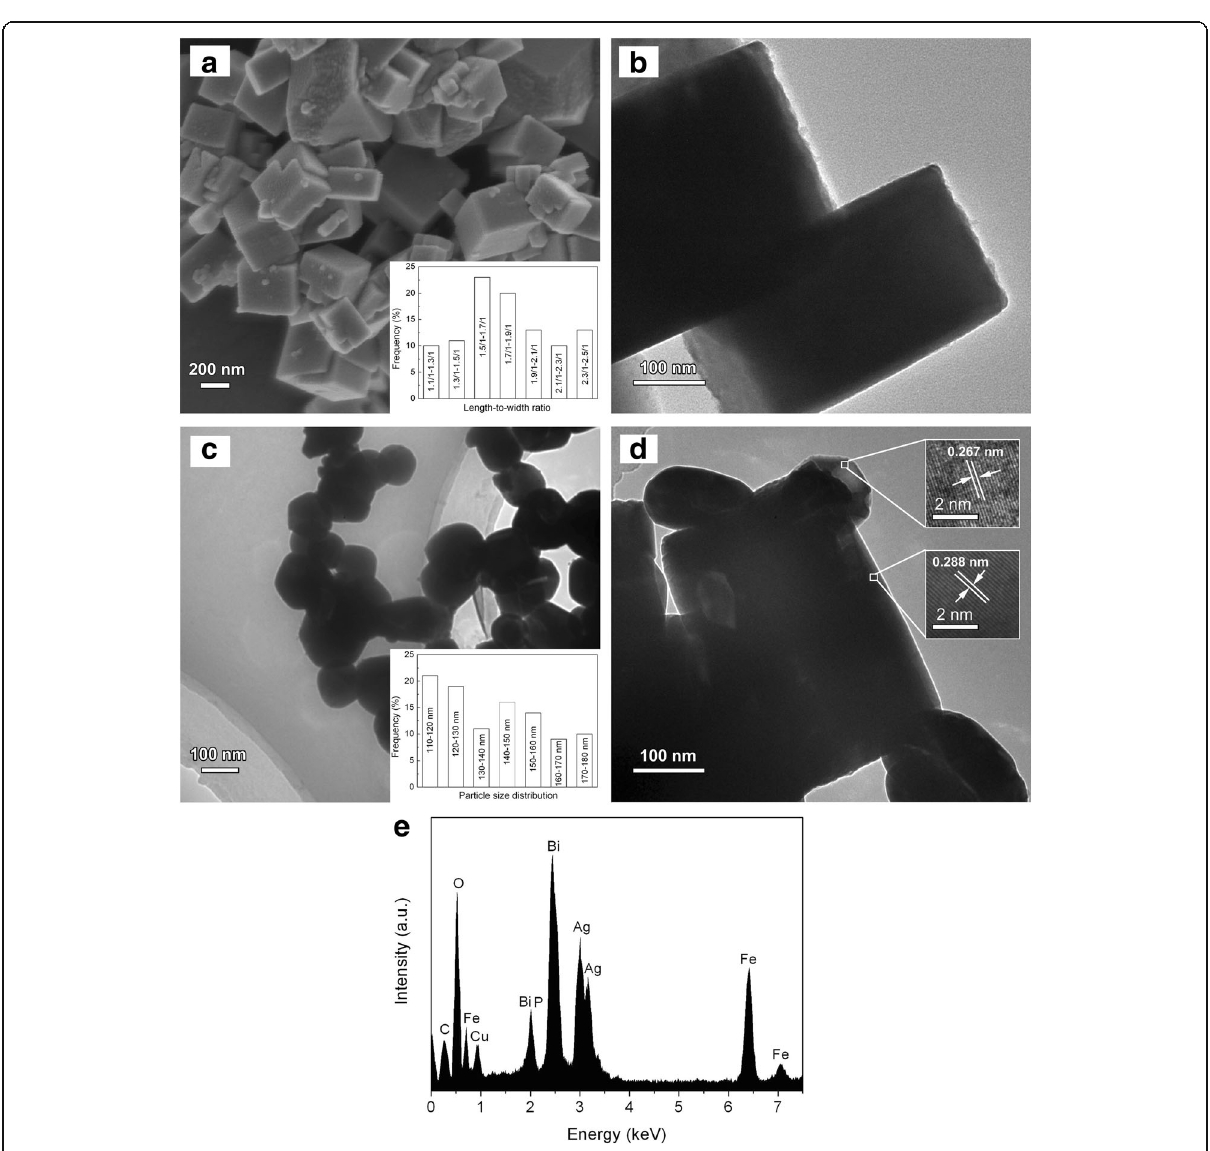
Fig. 2 a SEM (the inset is the length-to-width ratio distribution of BiFeO 3 microcuboids) and b TEM image of BiFeO 3 microcuboids. TEM image of c Ag 3 PO 4 microparticles (the inset is the size distribution of Ag 3 PO 4 microparticles) and d 20wt%Ag 3 PO 4 /BiFeO 3 sample; inset shows its HRTEM image. e EDX spectrum of 20wt%Ag 3 PO 4 /BiFeO 3